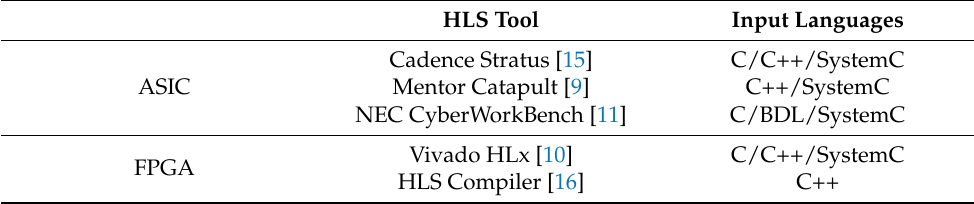
Table 1. Overview of commercial HLS tools and their supported input